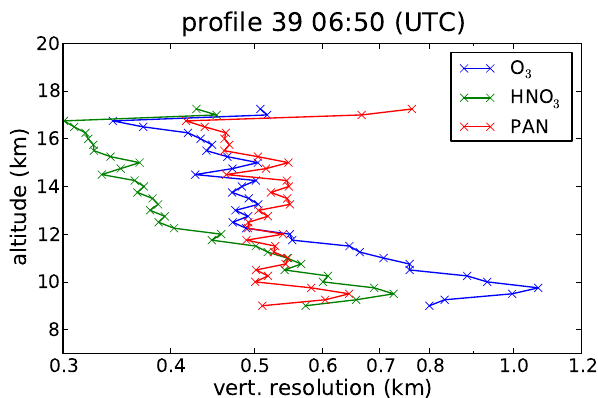
Fig. 4. Vertical resolution for retrieved O 3 , HNO 3 , and PAN VMRs for a representative profile of the western cross